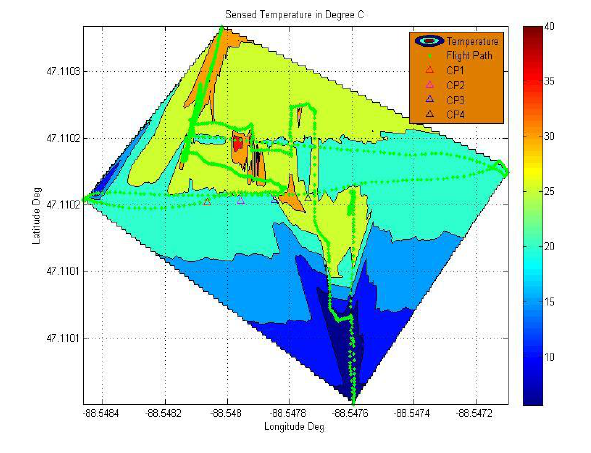
Figure 8. MATLAB visualization of temperature peaks from UAV flight (note: X and Y axis are not to